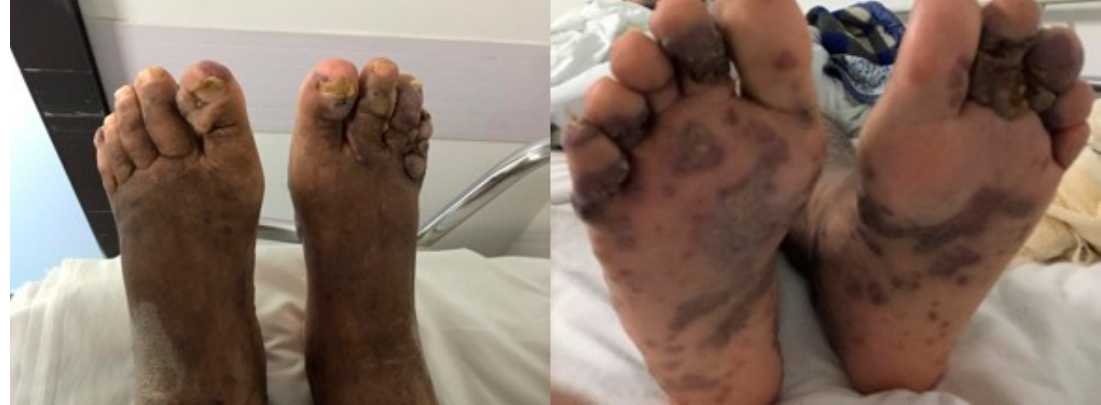
Figure 2. Disseminated Kaposi’s Sarcoma with Cutaneous Verruciform Kaposi in feet.